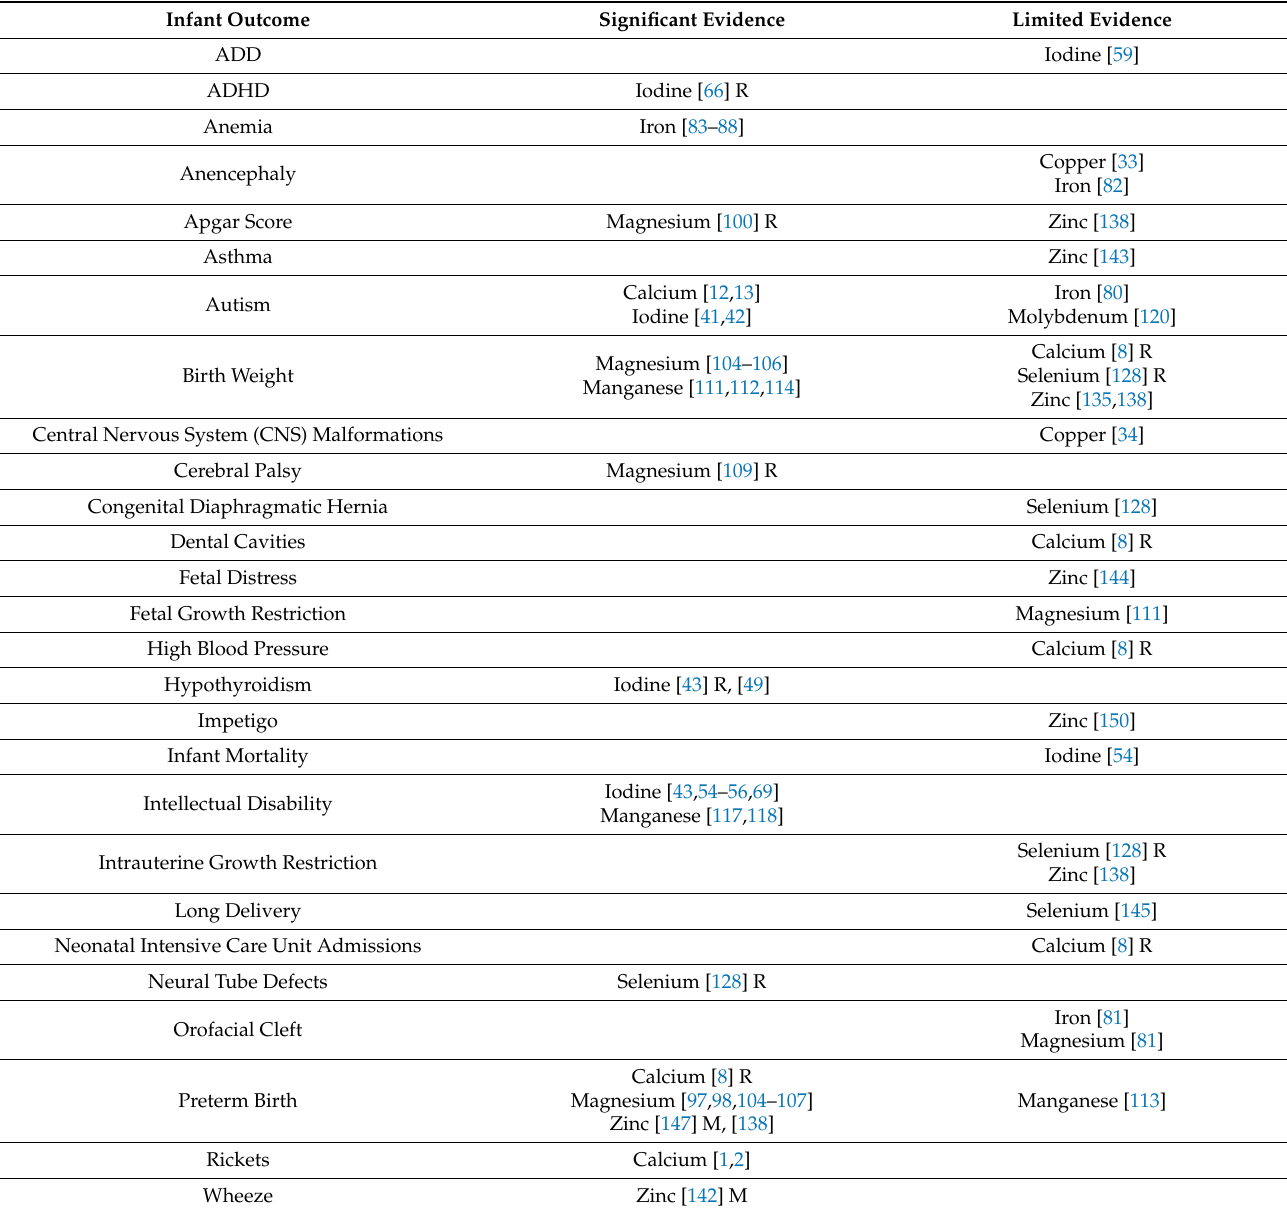
Table 2. Relationship of infant health problems to maternal mineral status